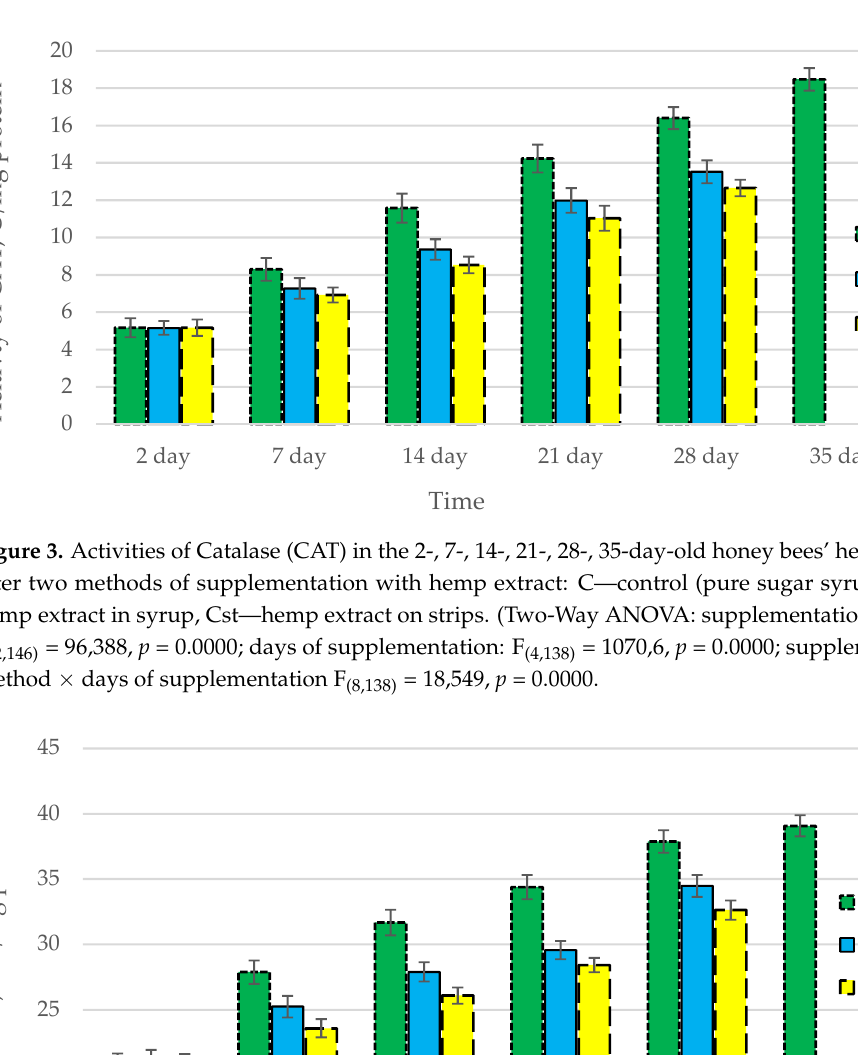
Figure 2. Activities of Superoxide Dismutase (SOD) in the 2-,7-,14-,21-,28-,35-day-old honey bees’ hemolymph after two methods of supplementation with hemp extract: C–control (pure sugar syrup), Csy–hemp extract in syrup, Cst–hemp extract on strips. (Two-Way ANOVA: supplementa- tion method: F (2,146) = 66,223, p = 0.0000; days of supplementation: F (4,138) = 1888,5, p = 0.0000; supple-